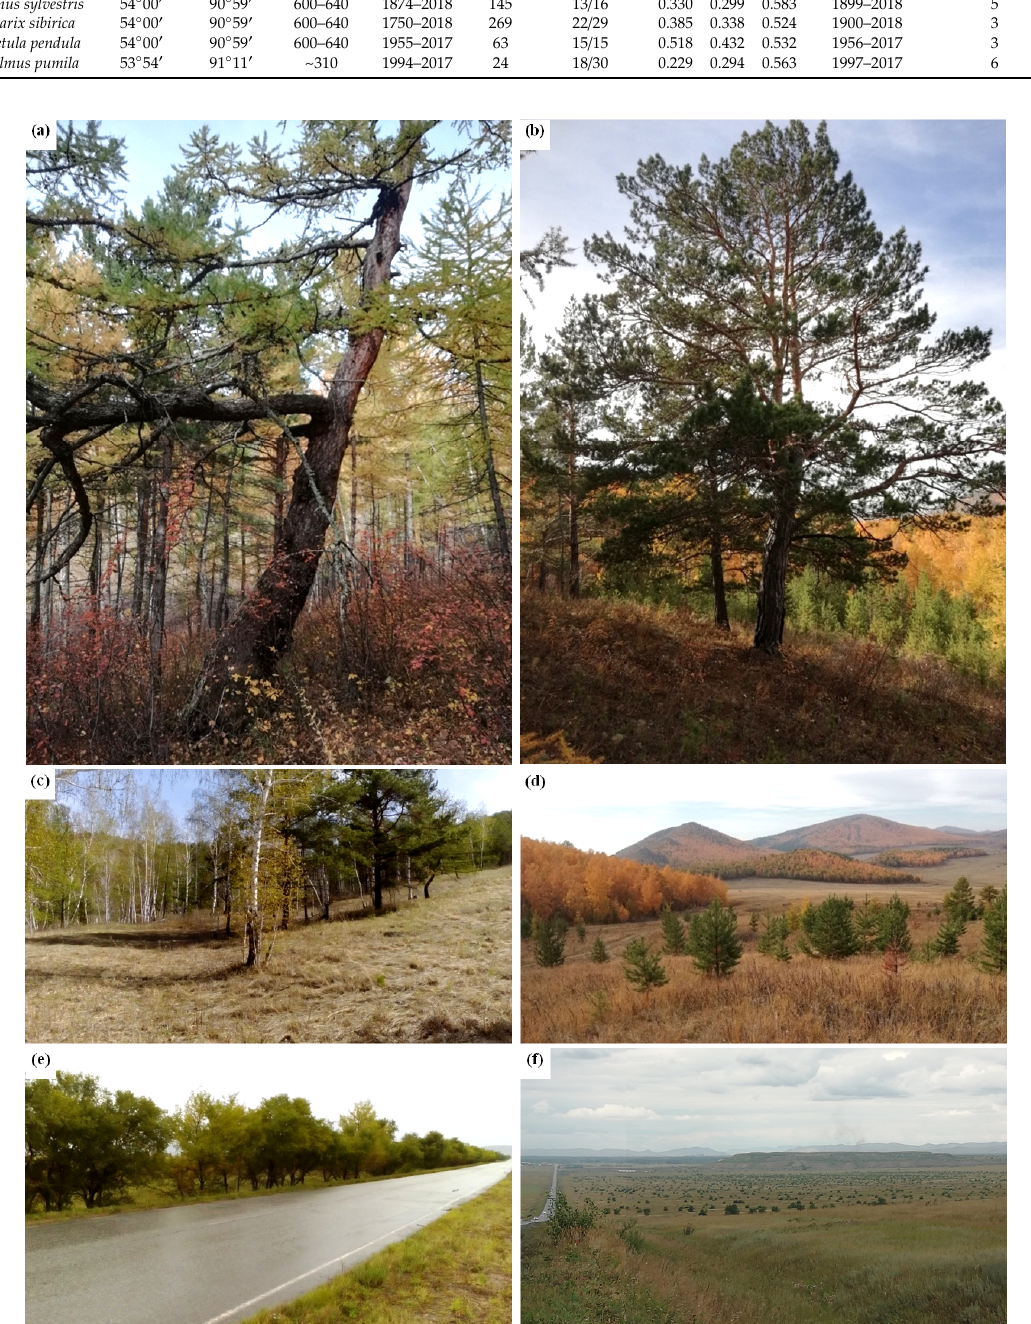
Figure 2. Sampling sites: ( a ) mature larch tree at the main site; ( b ) mature pine tree at the main site; ( c ) general view of the forest stand at the main site; ( d ) young pine trees on the forest boundary at the main site; ( e ) elm shelter belt; ( f ) steppe overgrowing with elm.